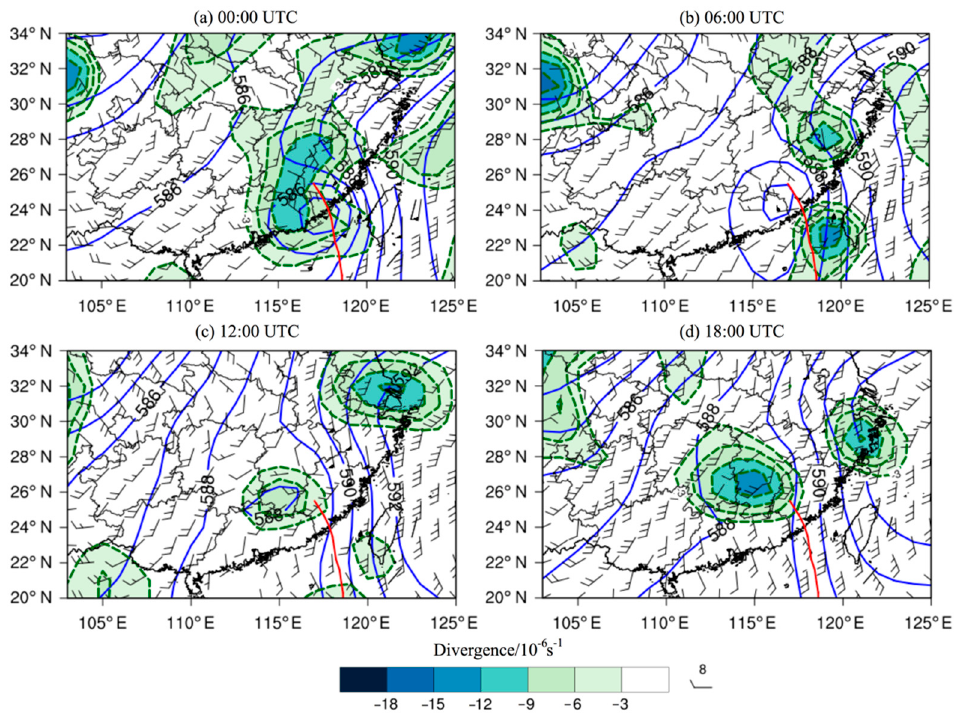
Figure 8. Synoptic situation of geopotential height (blue, contour interval is 1, unit: dagpm) at 500 hPa, wind (unit: m/s) and divergence (color area, unit: 10 − 6 m − 1 ) at 700 hPa every 6 h from 00:00 to 18:00 UTC on 11 August 2020. The red line stands for best track of typhoon Mekkhala (2020).